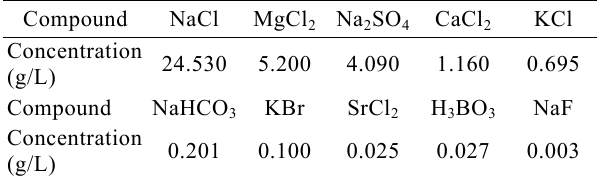
Table 3 Chemical compositions of the artificial